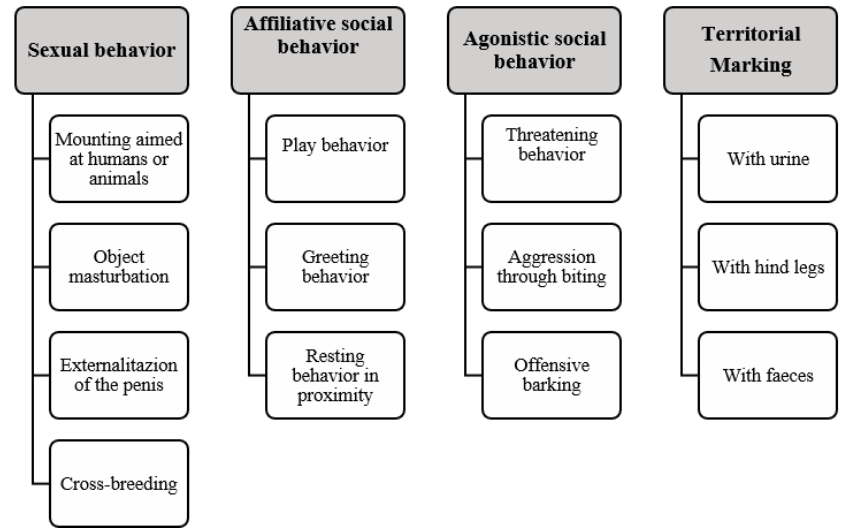
Figure 1. Behavioral groups and behavior subcategories considered in the survey directed at dog owners in the study.